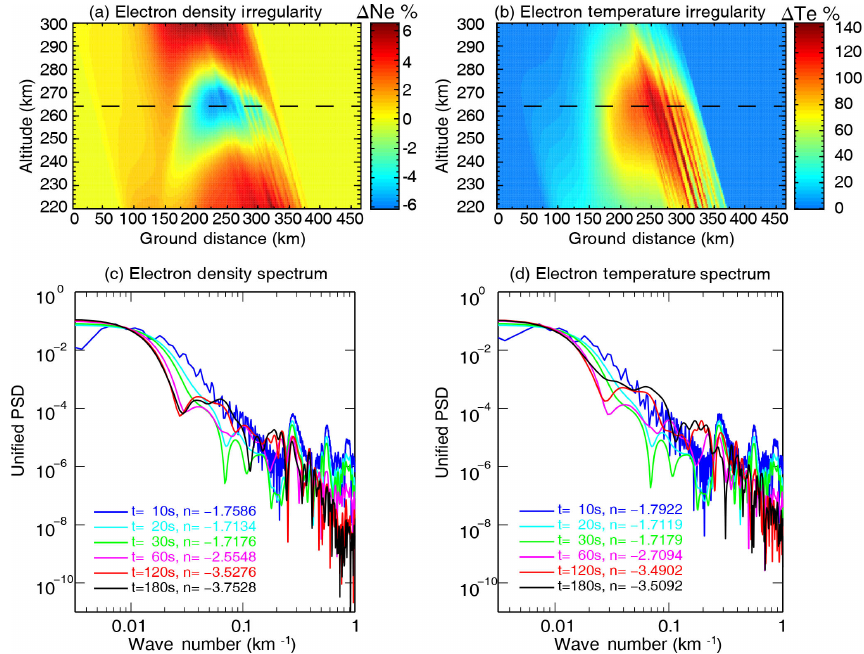
Figure 9. The same format as Fig. 8, but with heating wave incidence perpendicular to the magnetic field